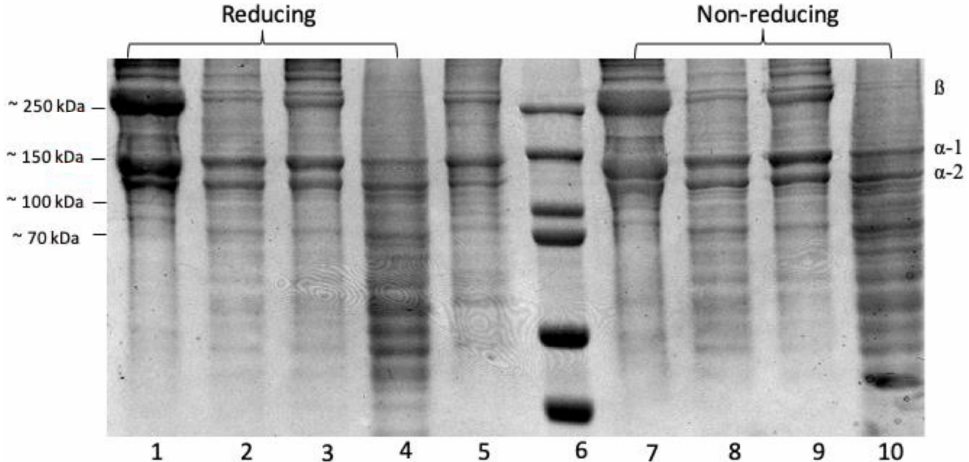
Figure 2. SDS-PAGE- Electrophoresis analysis of collagen extractions from the skin of purple-spotted bigeye: (reducing 1–4); Lane 1, Acetic acid; lane 2, Citric acid; lane 3, Lactic acid; lane 4, Pepsin; lane 5, type I collagen from bovine and lane 6, protein marker; (non-reducing 7–10); Lane 7, Acetic acid; lane 8, Citric acid; lane 9, Lactic acid; lane 10,